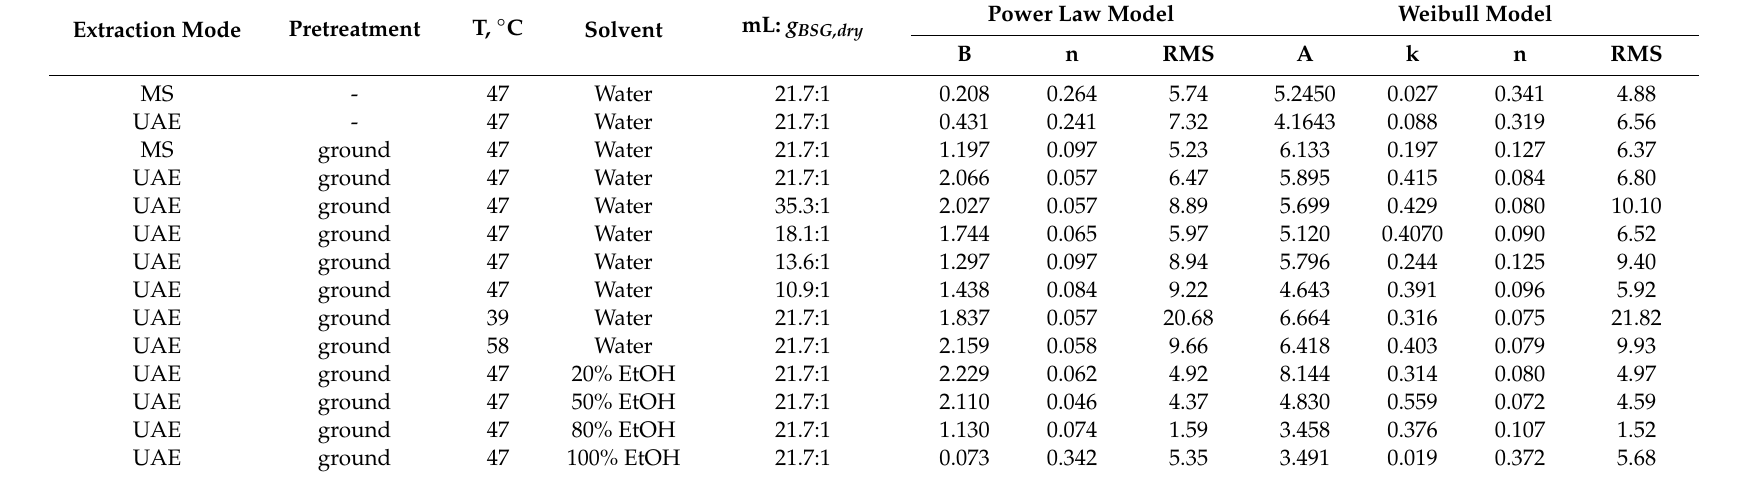
Table 3. Kinetic model parameters for TPC extraction from